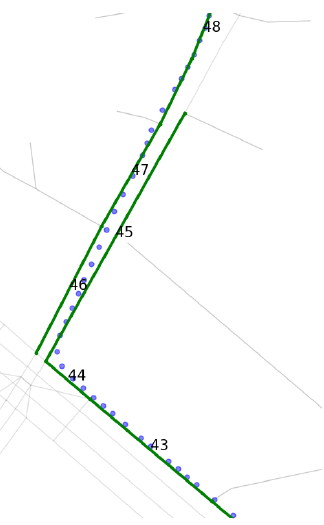
Figure 5. Cat-IV error : ambiguous lane